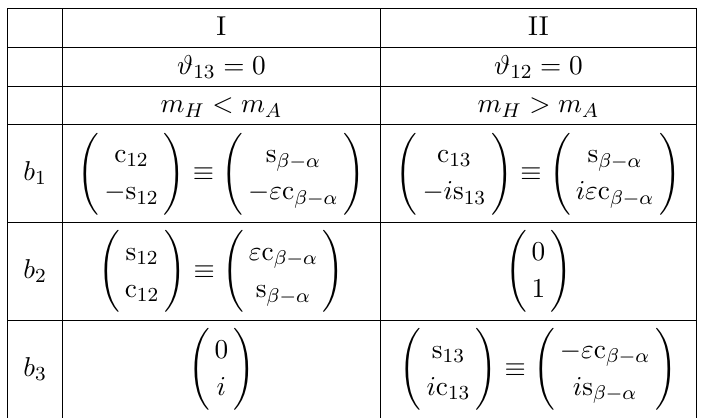
Basis-independent conditions for a CP-conserving 2HDM scalar potential and va- cuum [19]. # ij are the mixing angles of the neutral Higgses and (cid:12) (cid:0) (cid:11) is the invariant angle constructed from the angle (cid:11) which mixes the CP-even Higgs bosons and the angle (cid:12) which relates the values of the VEV’s; " (cid:17) sgn( (cid:12) (cid:0) (cid:11) ) is a pseudo-invariant quantity; m H and m A denote the masses for the CP-even and CP-odd Higgses. Relations between neutral Higgs (cid:12)elds and angular factors are explained in more detail in appendix C and in ref. [23]. Our case I corresponds to the case I of [19], whereas our case II corresponds to the case IIa of